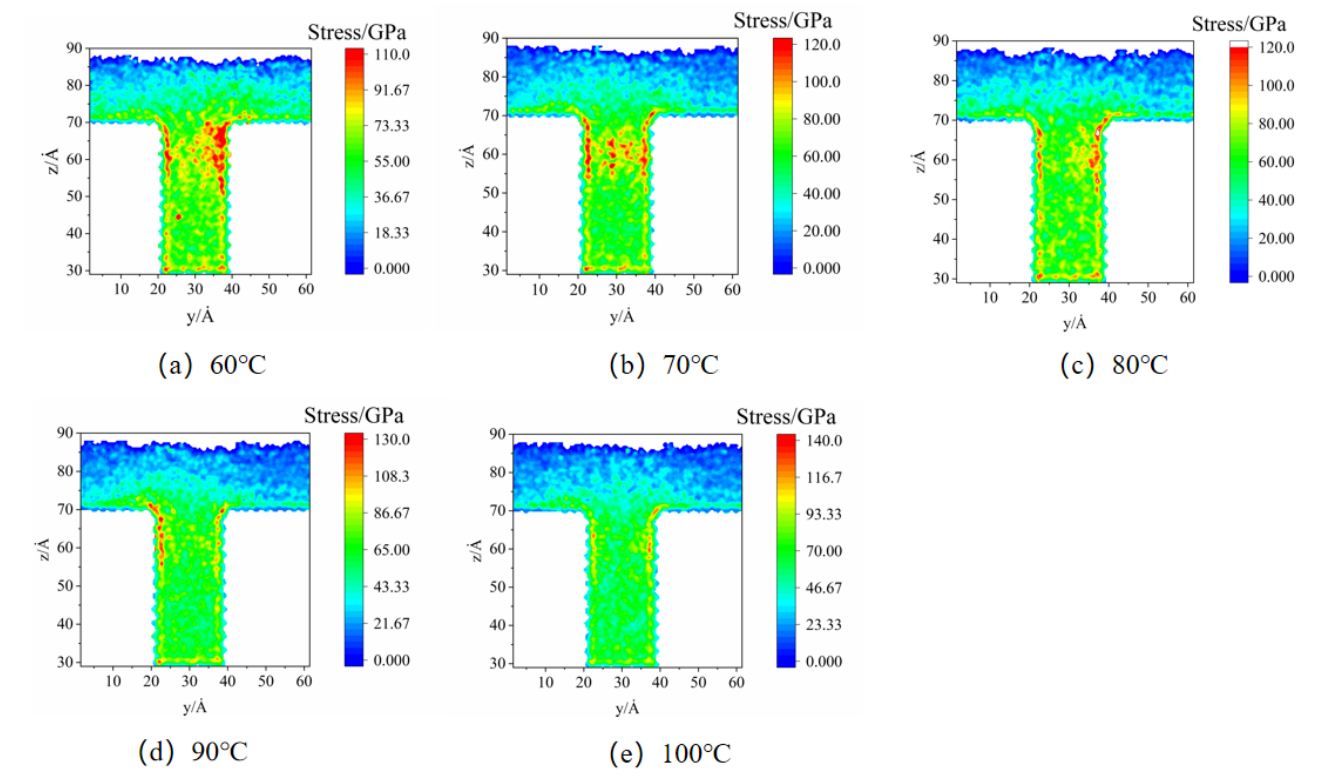
Figure 8. Stress distributions at different mold temperatures in MD simulation.